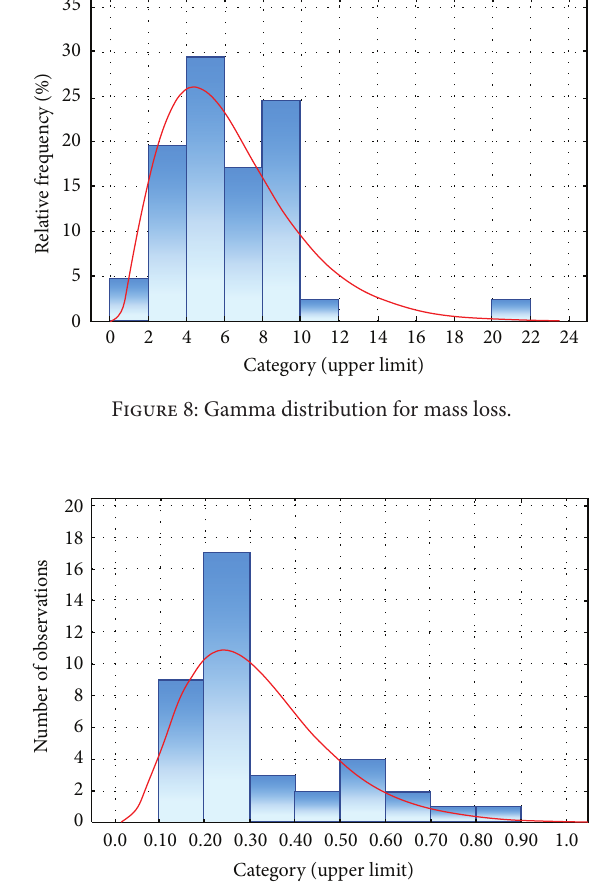
Figure 9: Distribution of pit depth for an embedded sample with a mass loss of 2.23%.